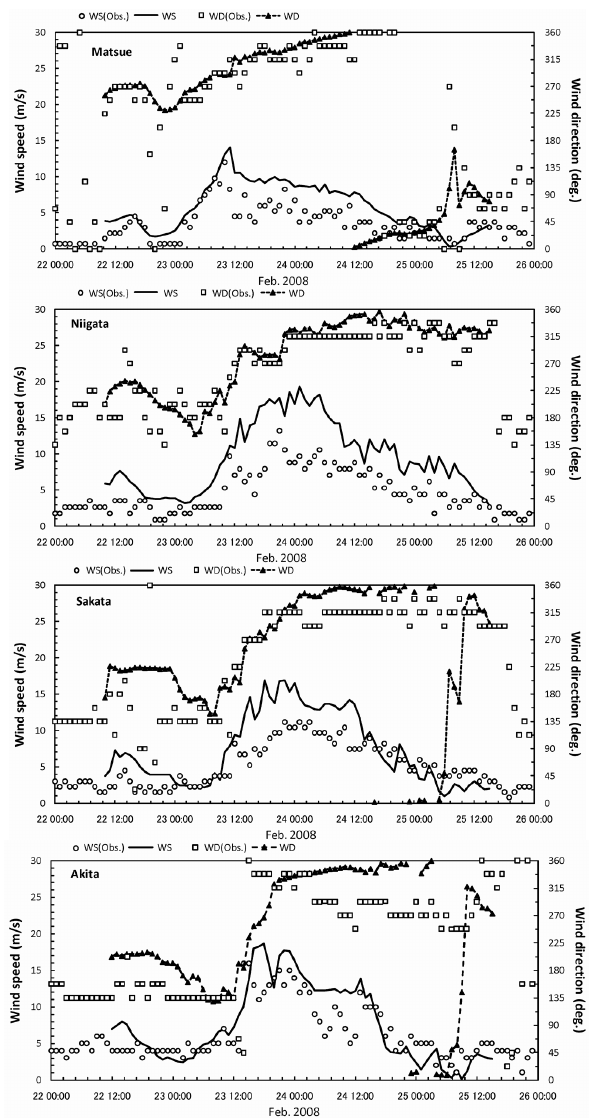
Fig. 13. Comparisons of observations and calculations of winds at Matsue, Niigata, Sakata and Akita in Japan for the event of February 2008. 7